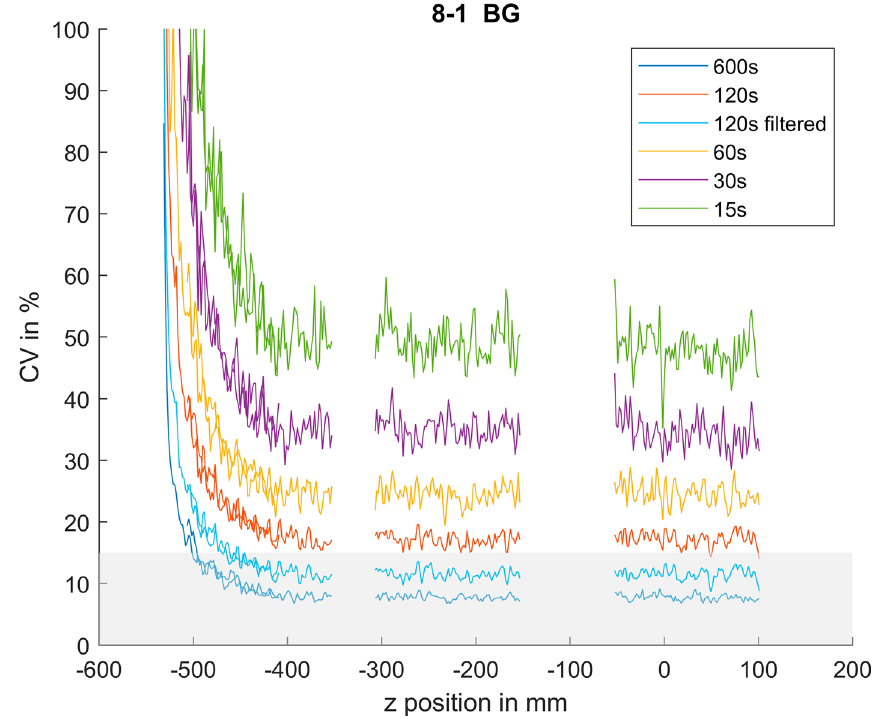
Fig. 2 Image noise expressed as CVs [%] for the different acquisition times and axial imaging positions including an example of a filtered data set (120 s with 3 mm FWHM Gaussian